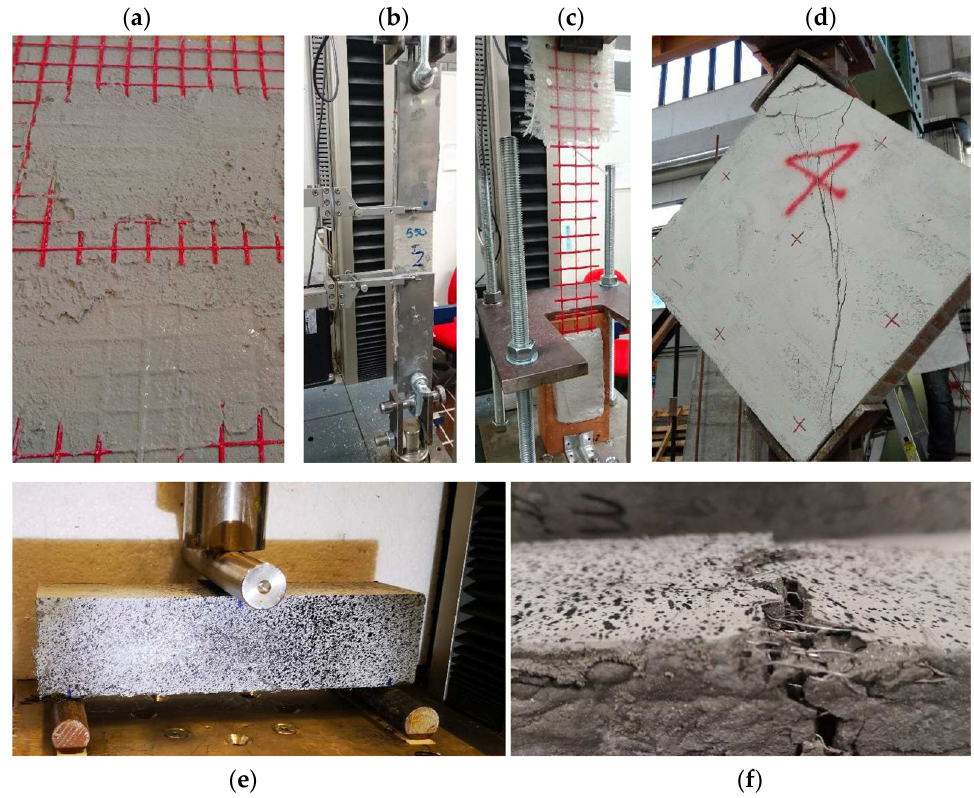
Figure 3. Inorganic matrix composite systems: ( a ) FRCM made of glass fabric and cementitious mortar; ( b , c ) mechanical characterization tests of FRCM systems; ( d ) diagonal compression test on masonry reinforced with CRM; ( e , f ) three-point bending test on a UHPFRC specimen and detail of the steel fibers after cracking.